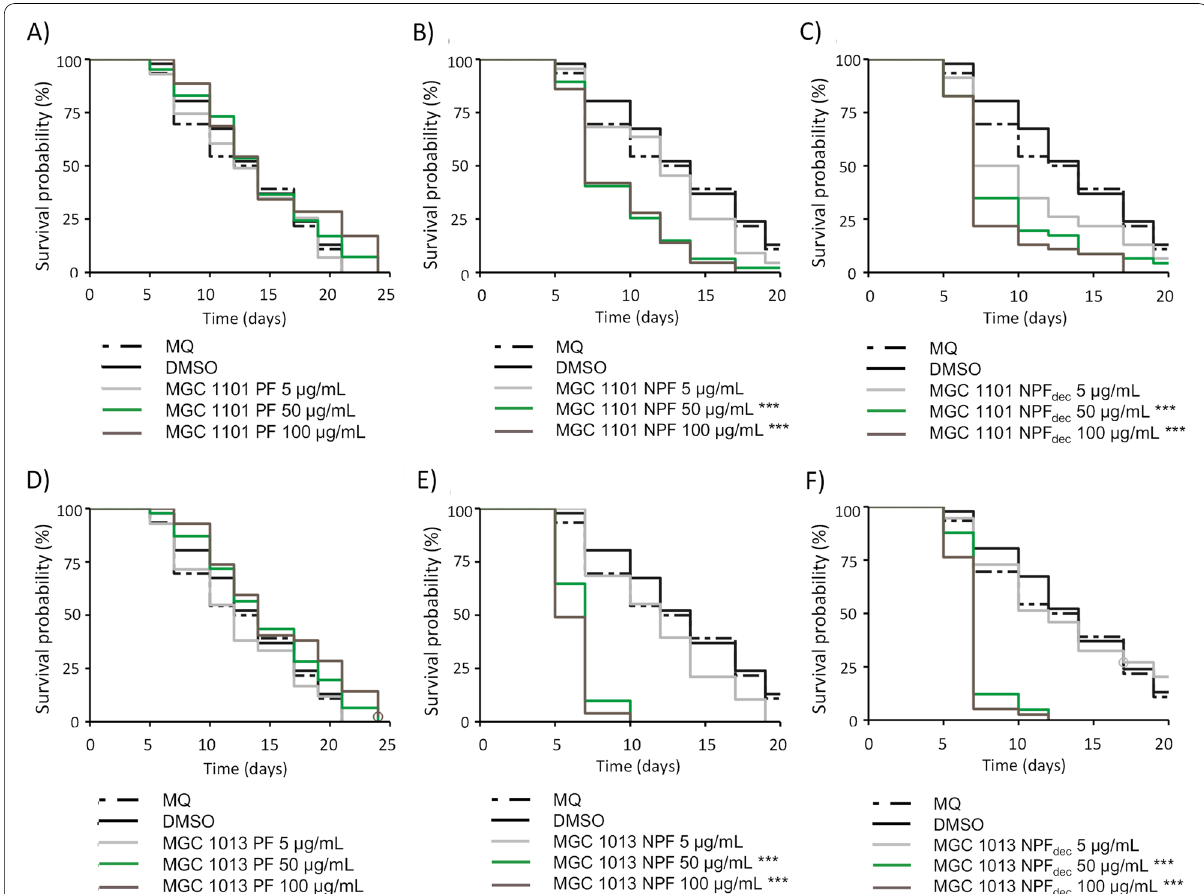
Fig. 1 Kaplan‑Meier survival rate of C. elegans exposed to different types of cannabis. C. elegans was exposed to 5, 50, and 100 μg/mL extracts obtained from the Δ 9 ‑tetrahydrocannabinol (THC)‑rich cannabis variety MGC 1101 ( A – C ) and the cannabidiol (CBD)‑rich variety MGC 1013 ( D – F ). Vehicle control (Milli‑Q water (MQ)/dimethyl sulfoxide (DMSO)) and different doses of A polar fraction (PF) of MGC 1101; B non‑polar fraction (NPF) of MGC 1101; C decarboxylated non‑polar fraction (NPF dec ) of MGC 1101; D PF of MGC 1013; E NPF of MGC 1013; F NPF dec of MGC 1013. Kaplan‑Meier survival analysis was used to compare the vehicle control (DMSO) condition to the experimental conditions. * (FDR)‑corrected p < .05; *** FDR‑corrected p < =